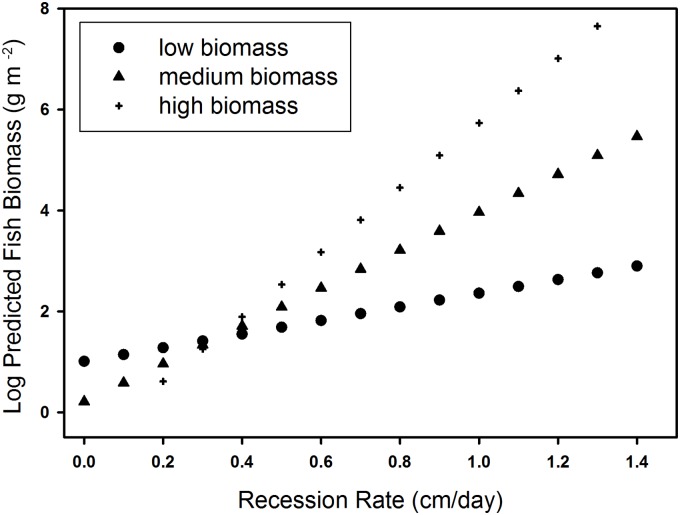
The relationship between predicted dry-season fish biomass (y-axis) and recession rate (x-axis).Low (circles), medium (triangle) and high (cross) levels of wet season biomass.